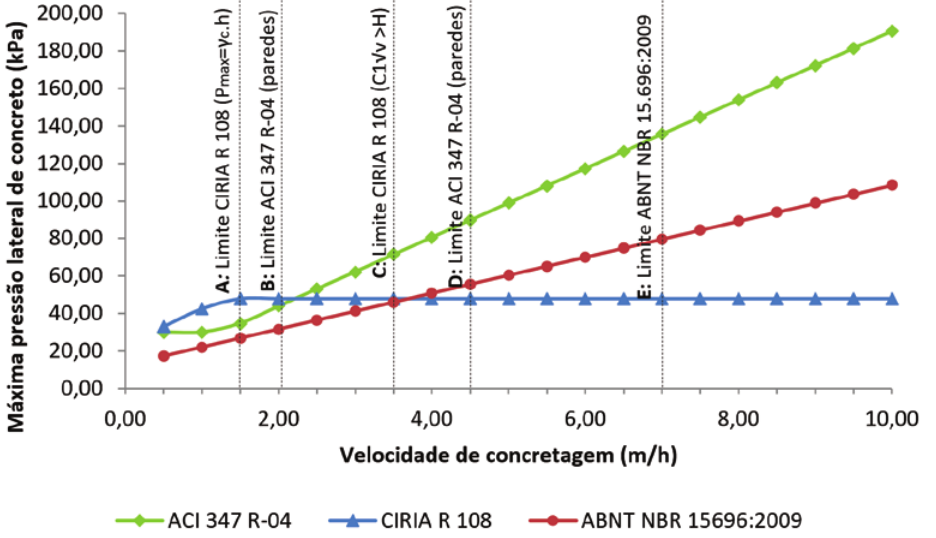
Influência da velocidade de concretagem sobre a pressão lateral do concreto fresco calculada a partir de diferentes métodos de